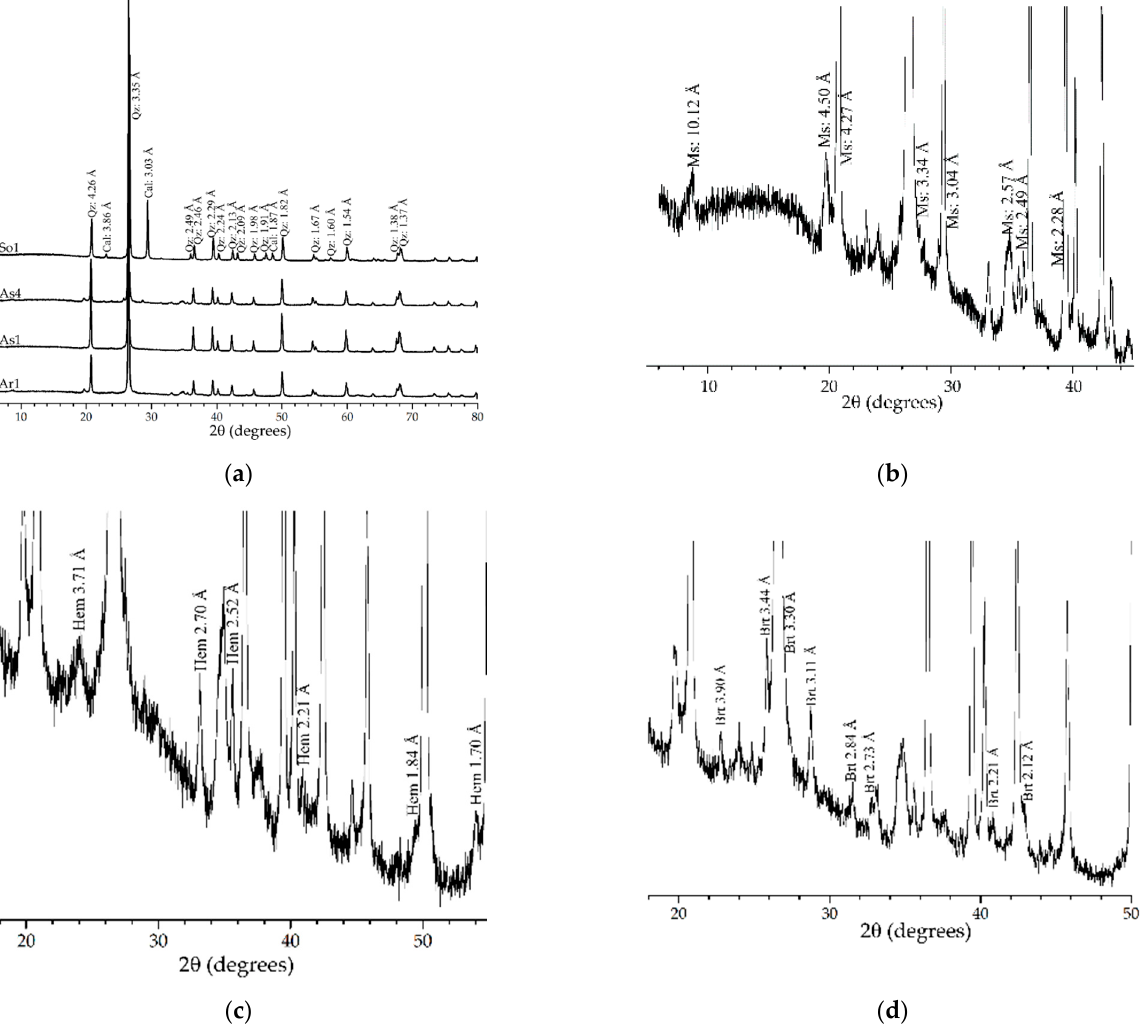
Figure 6. X-ray diffraction patterns of the chert samples from inland outcrops showing reflections of quartz, Qz, and calcite, Cal, ( a ); muscovite, Ms, ( b ); hematites, Hem, ( c ) and barite, Brt, ( d ). Table 2. Values of 2 θ of the (101) reflection of quartz and FWHM (2 θ ◦ ) used to obtain the crystallite size and lattice strain, and values of 2 θ of the (212) reflection of quartz to obtain the crystallinity index of Murata of the chert samples of the coastal and inland